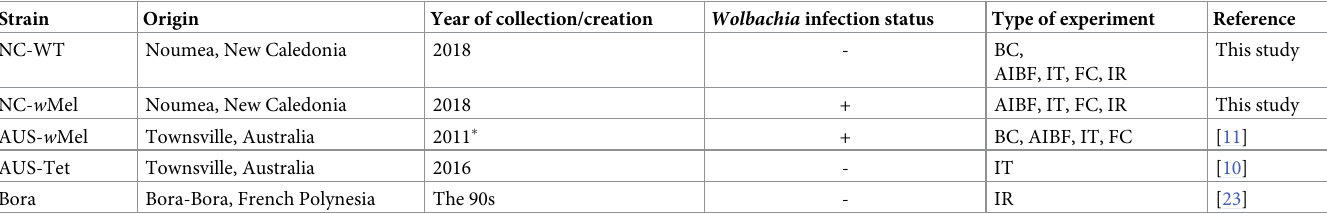
Table 1. Origin, status of Wolbachia infection and use of Aedes aegypti